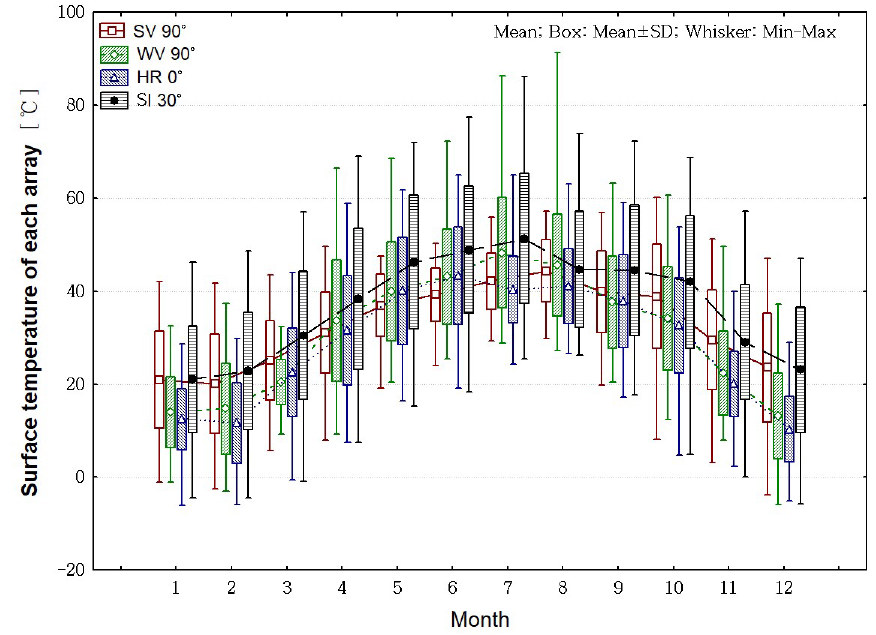
Figure 5. Monthly module surface temperature of each array.